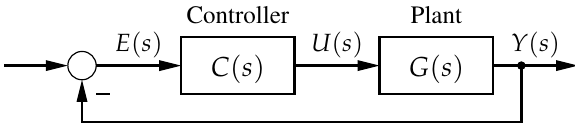
Figure 4. Simplified structure of the closed control loop.